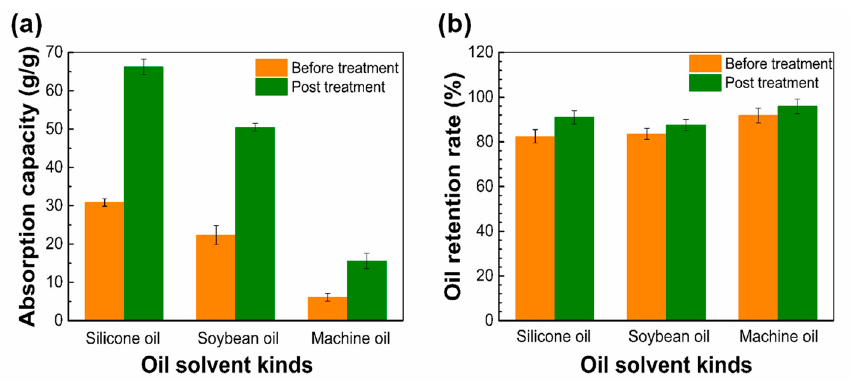
Figure 13. ( a ) Oil absorption ratio of fiber membrane before and after acetone treatment; ( b ) Oil retention rate of fiber film before and after acetone treatment.